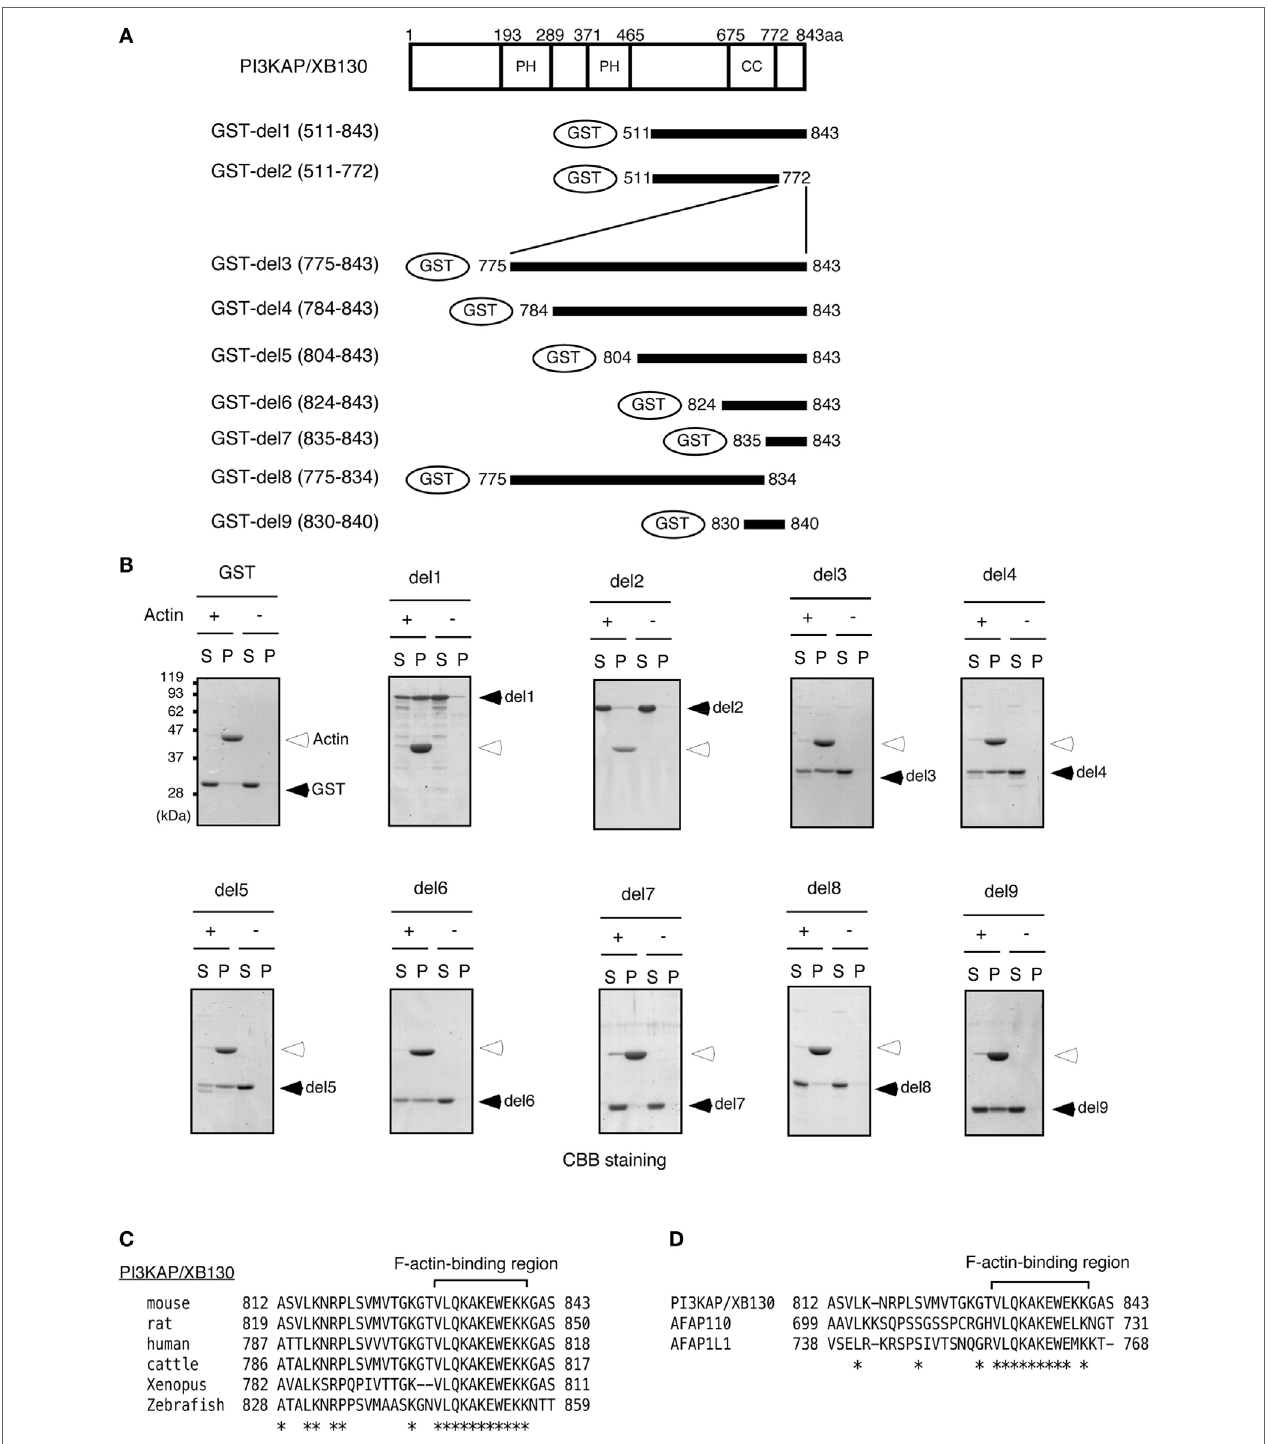
FigUre 2 | Pi3KaP/XB130 binds to actin filaments . (a) The GST-fused PI3KAP/XB130 deletion constructs used in the experiments are shown. The numbers indicate the amino acid residues from the N-terminal end of PI3KAP/XB130. PH, PH domain; CC, coiled-coil domain. (B) Actin filaments polymerized in vitro were incubated with GST or GST-fused PI3KAP/XB130 deletion mutants. The mixture of actin filaments and GST-fusion proteins was subjected to ultracentrifugation, and the fractions of supernatant (S) and pellet (P) were separated by SDS-PAGE and then proteins were visualized by CBB staining. (c,D) Alignment of amino acid sequences of F-actin-binding region of PI3KAP/XB130 among mouse, rat, human, cattle, frog, and zebrafish (c) or among mouse PI3KAP/XB130, AFAP-110, and AFP1L1 (D) . The asterisks indicate identical amino acid residues.